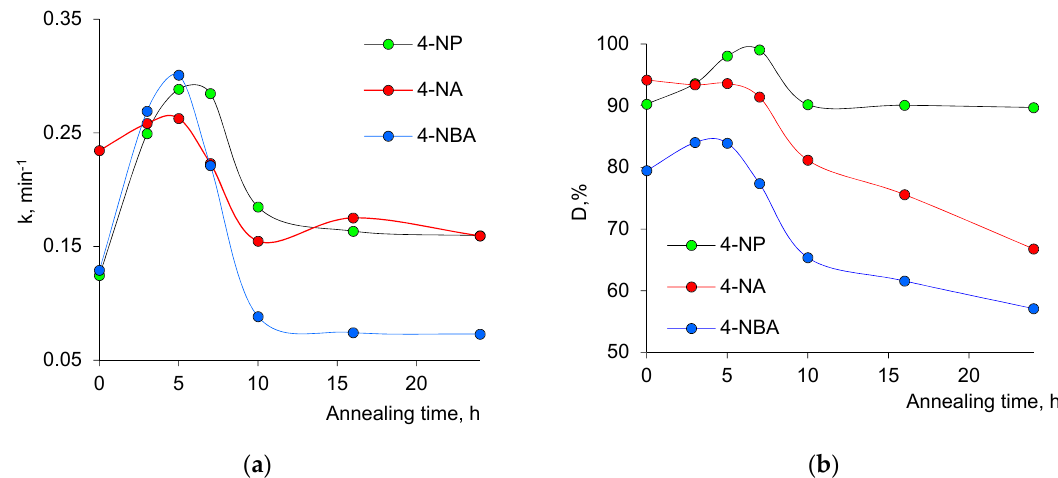
Figure 8. Composite track-etched membrane catalyzed reduction of aromatic nitro compounds: change of the rate constant, k ( a ), and degree of hydrogenation, D ( b ), as a function of annealing time at 140 °C.